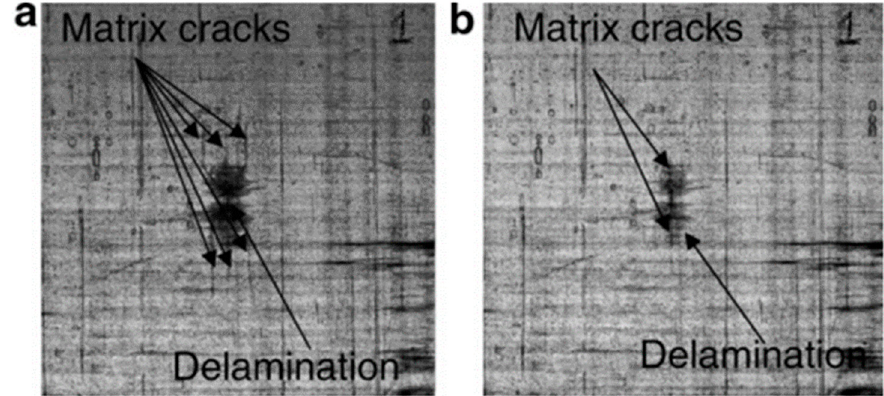
Figure 3. Glass-fiber composite panel impacted: ( a ) before and ( b ) after a healing cycle. (Reproduced from [48] with permission from Elsevier).